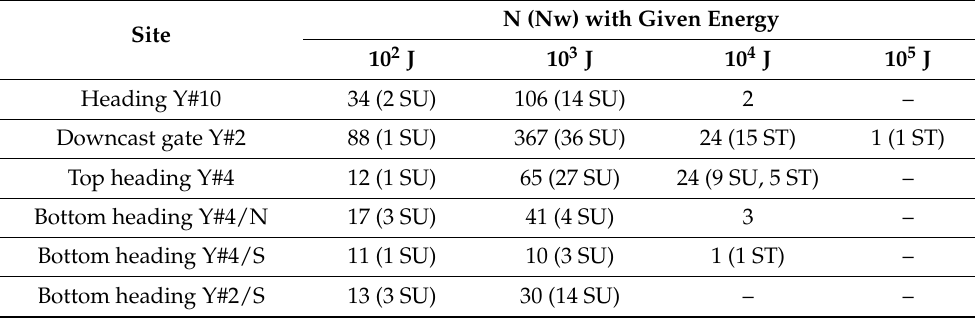
Table 3. Quantitative proportion of mining-induced events to the number of all recorded